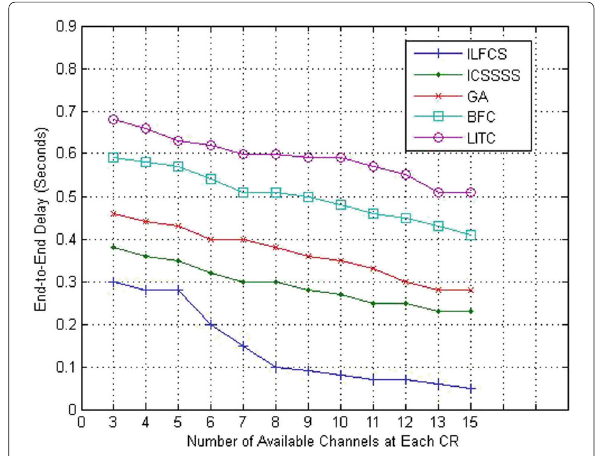
Fig. 14 Packet delivery ratio under different number of available channels. The results of different simulation experiments to Packet delivery ratio at different numbers of available channels for the BFC, LITC, GA, ICSSSS and the ILFCS are shown